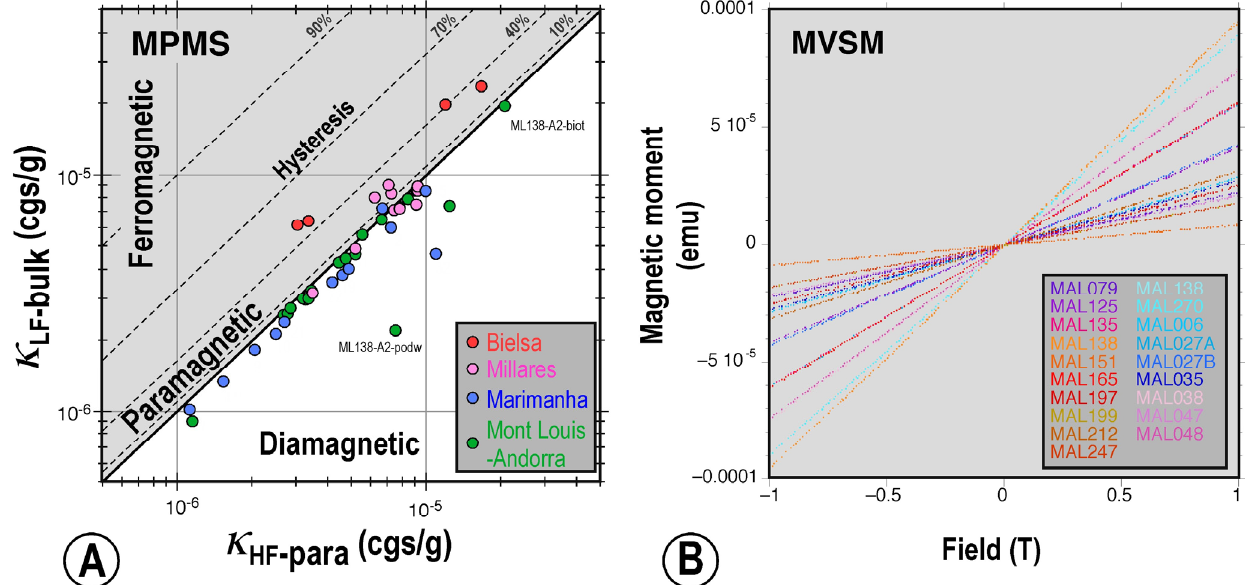
Figure 5. ( A ) HF vs. LF susceptibility data obtained in minicores in the MPMS instrument for selected samples of the MLA granite (this work), the Marimanha pluton (Antol í n et al. [46]) and compared with samples from other Pyrenean granites (data from Bielsa and Millares granites by Rom á n-Berdiel et al. [84,85]). ( B ) Induced magnetic moment (emu) as a function of the external magnetic field (T). All samples from Mont-Louis Andorra granite (MLA).